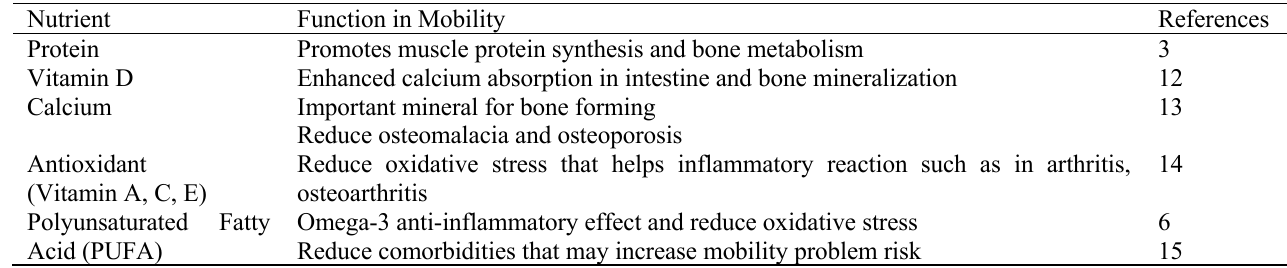
Table 1 . Nutrient’s function in mobility